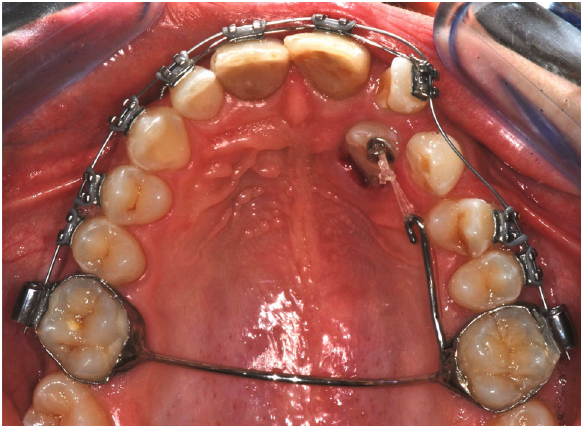
Figure 6: Intraoral photo 1 month after surgery with active elastic traction on 2.3 and upper arch